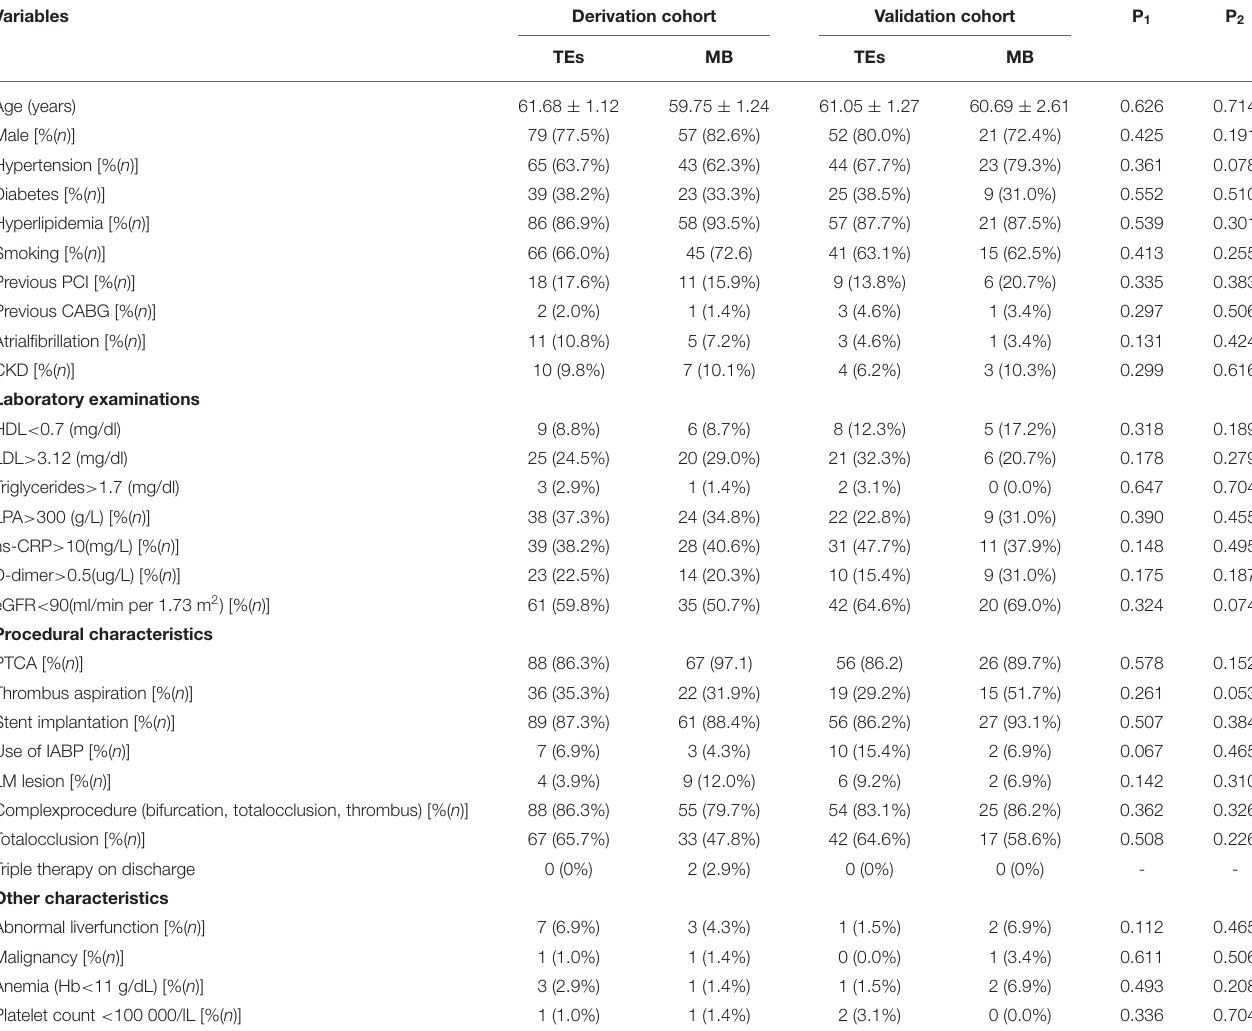
TABLE 1.2 | Baseline clinical characteristics of subgroup patients with vs. without thrombotic events or major bleeding. events.